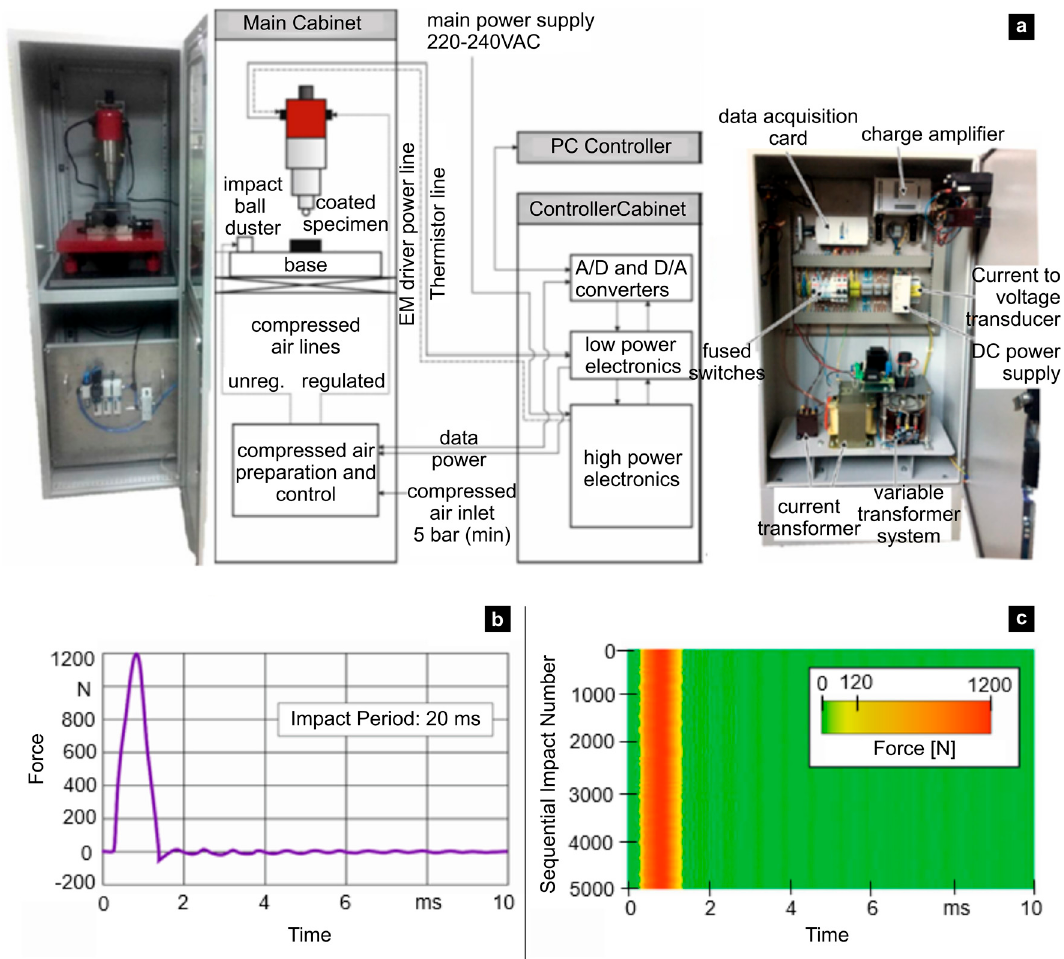
Figure 1. ( a ) Applied electro-magnetic impact tester for impact durations of less than 1 ms; ( b ) impact force course versus the time; ( c ) impact force at the sequent impacts.